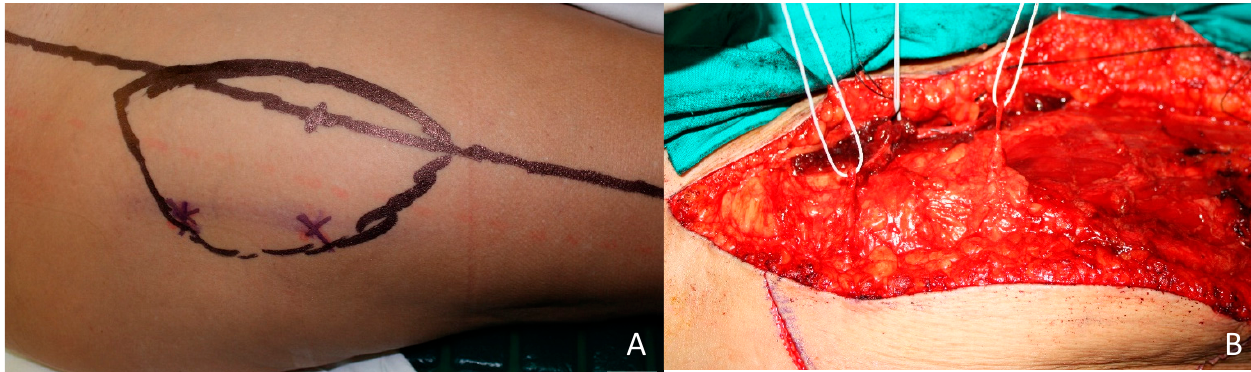
Figure 7. ALT flap. Squamous cell carcinoma of the parietal and temporal region.